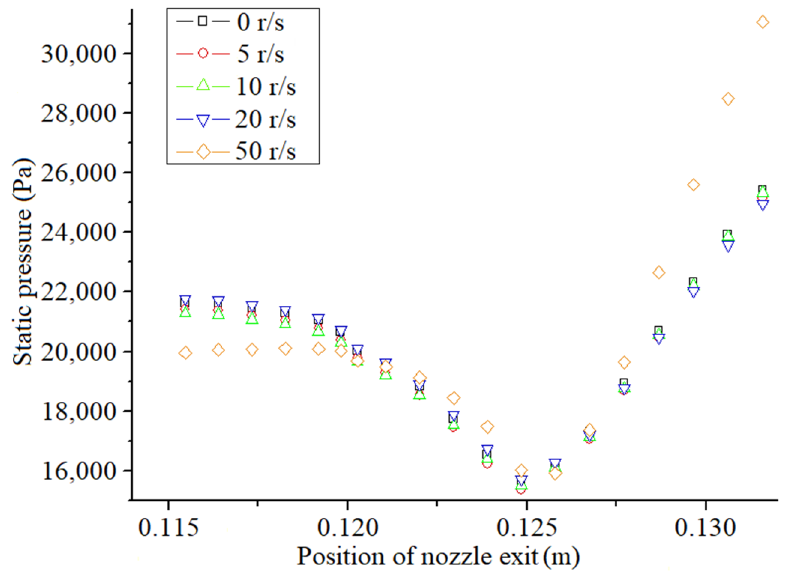
Figure 19. Static pressure distribution of the right nozzle exit at different rotational angular velocities.